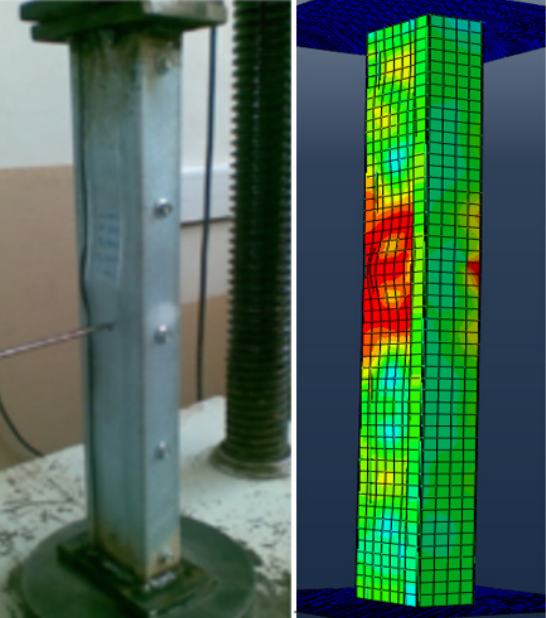
Figure 5. Deformed shapes at failure from the experiment [2] and FEA. Table 2. FE validation.